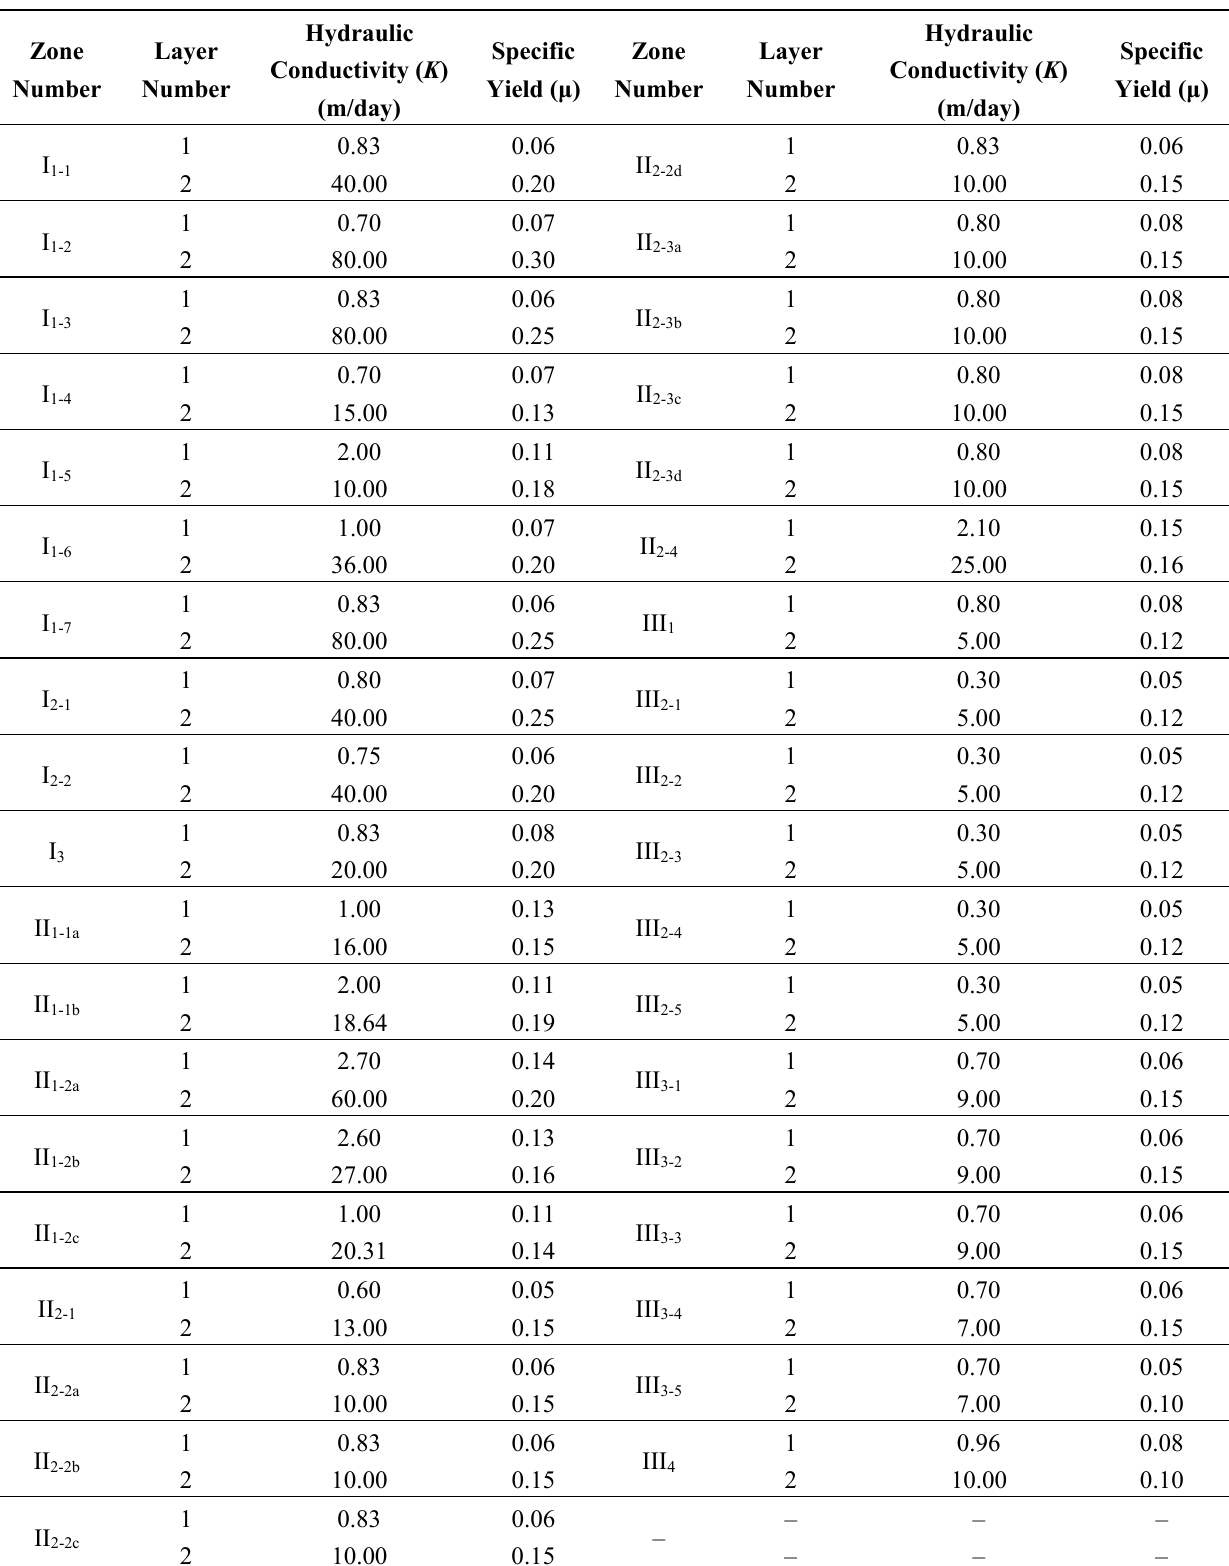
Table 1. Final parameters results for each